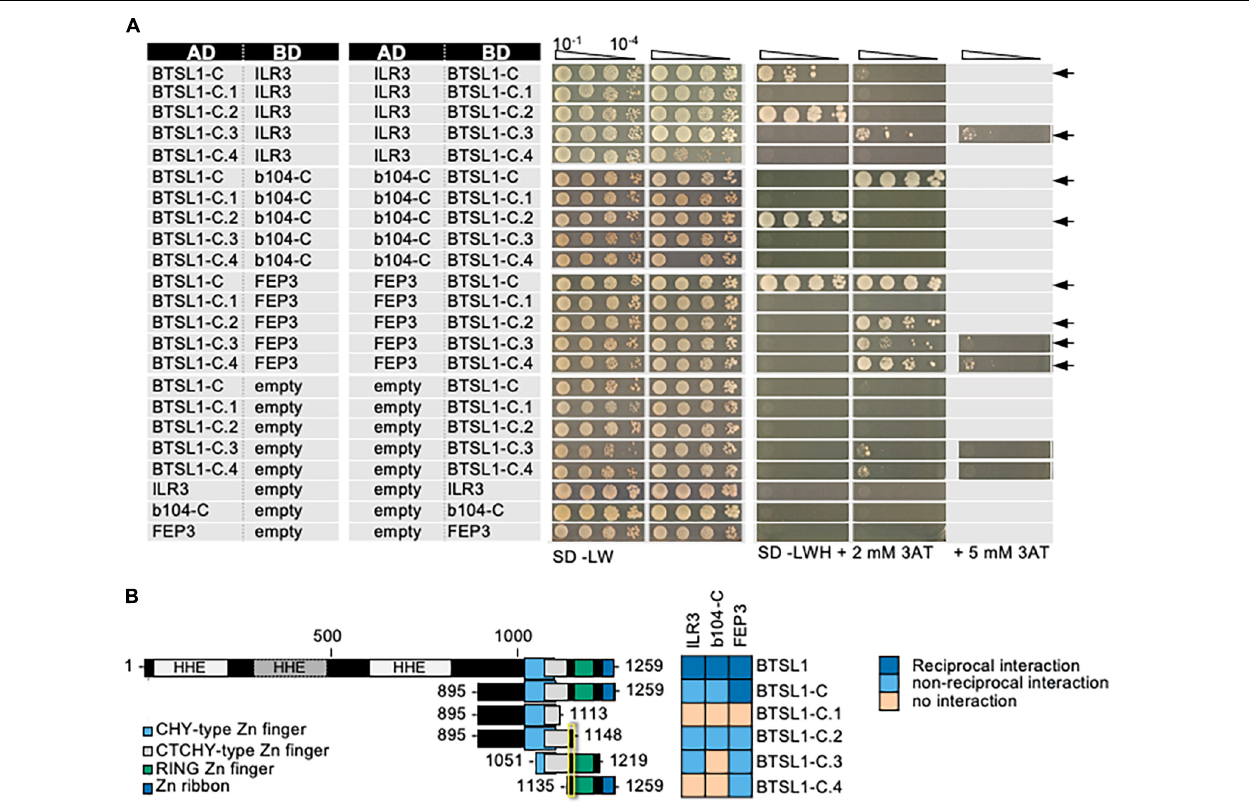
FIGURE 3 | Mapping of the interaction sites in BTSL1 by yeast two hybrid (Y2H) assays. BTSL1-C and deletion forms of BTSL1-C were tested in reciprocal targeted Y2H assays against ILR3, bHLH104-C (b104-C) and FEP3/IMA1. Yeast co-transformed with the AD and BD combinations were spotted in 10-fold dilution series (A 600 = 10 − 1 –10 − 4 ) on SD-LW (transformation control) and SD-LWH plates supplemented with different concentrations of 3AT as indicated (selection for protein interaction). Negative controls: empty vectors. Arrows indicate interaction. (B) Schematic representation and summary of Y2H results. Left, schematic representation of full-length BTSL1, BTSL1-C and deletion constructs of BTSL1-C.1 to –C.4, used for Y2H. The domains are indicated in color. The yellow box highlights the mapped interaction site for interaction with bHLH proteins and FEP3/IMA1. Right, summary results of panel (A) . The color code distinguishes reciprocal positive interactions (dark blue), non-reciprocal positive interactions (light blue), negative results on interactions (light